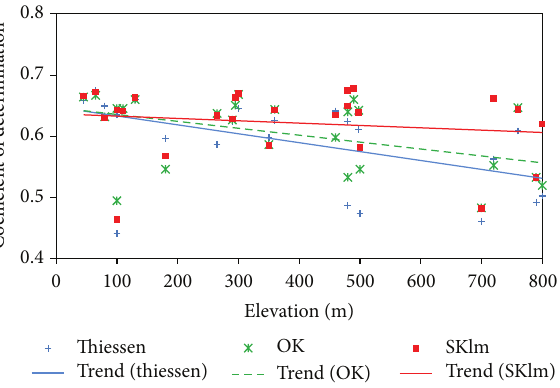
Figure 9: Trend of R 2 dependent on elevation.